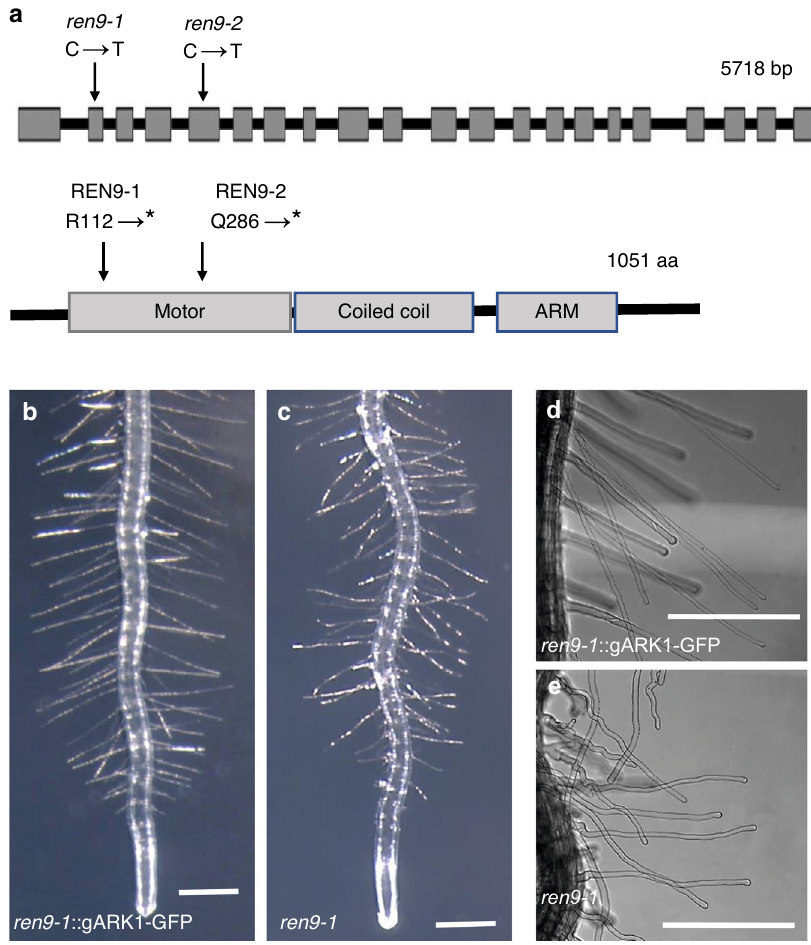
Fig. 3 Cloning of the REN9/ARK1 gene. Cloning of the REN9/ARK1 gene. a Schematic representation of the REN9/ARK1 genomic structure and protein domain organization. The genomic structure of 5718 bp is shown with exons (gray rectangles) and introns (black lines in the gene diagram). The ARK1 protein of 1051 aa is shown with motor, coiled coil and armadillo (ARM) domains (gray rectangles). Arrows indicate the single-base transition and resulting change of the amino acid residue in ren9-1 and ren9-2 . Asterisks indicate the stop codon. ( b – e) g ARK1 – GFP rescues the root-hair defect of ren9-1 . Root hairs of transgenic ( b , d ) and non-transgenic ren9-1 ( c , e ). Scale bars = 0.5